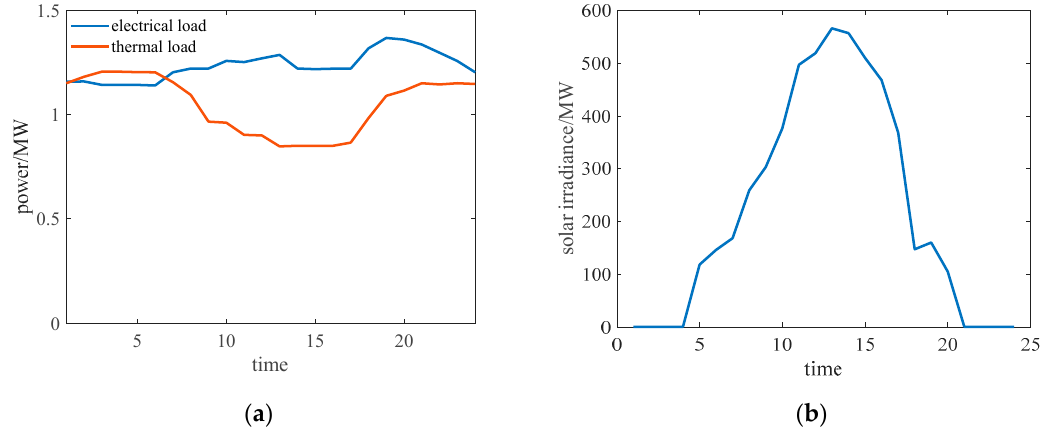
Figure 5. Data for the 24-h period cases. ( a ) Loads of the cases; ( b ) predicted irradiance intensity.